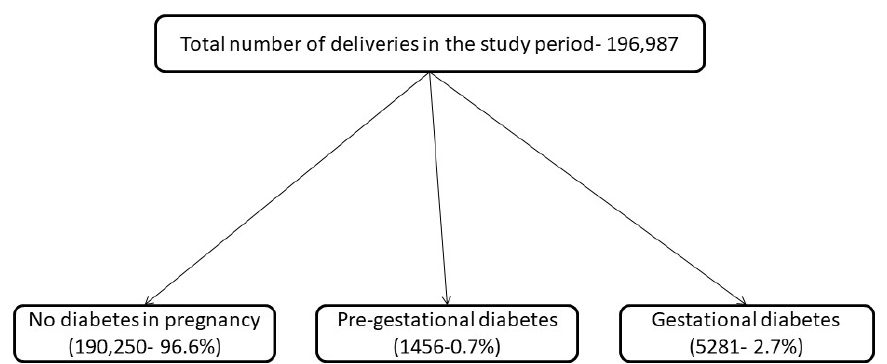
Figure 1. Flow diagram representing the study population.